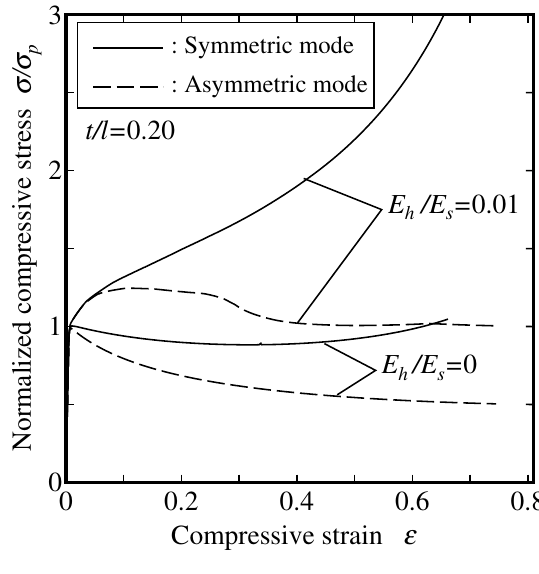
Figure 20. Stress-strain responses for an infinite honeycomb with t/l = 0 . 20 .